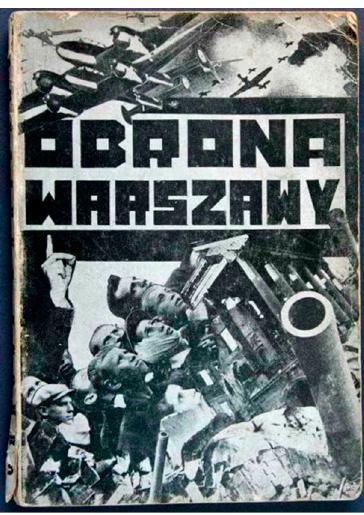
Figure 2. Teresa Ż arnower, front cover of the book The Defense of Warsaw. Polish people in defense of the capital (September 1939) , Format: 15 cm × 22 cm, 1942, courtesy of On Paper Store, Italy.